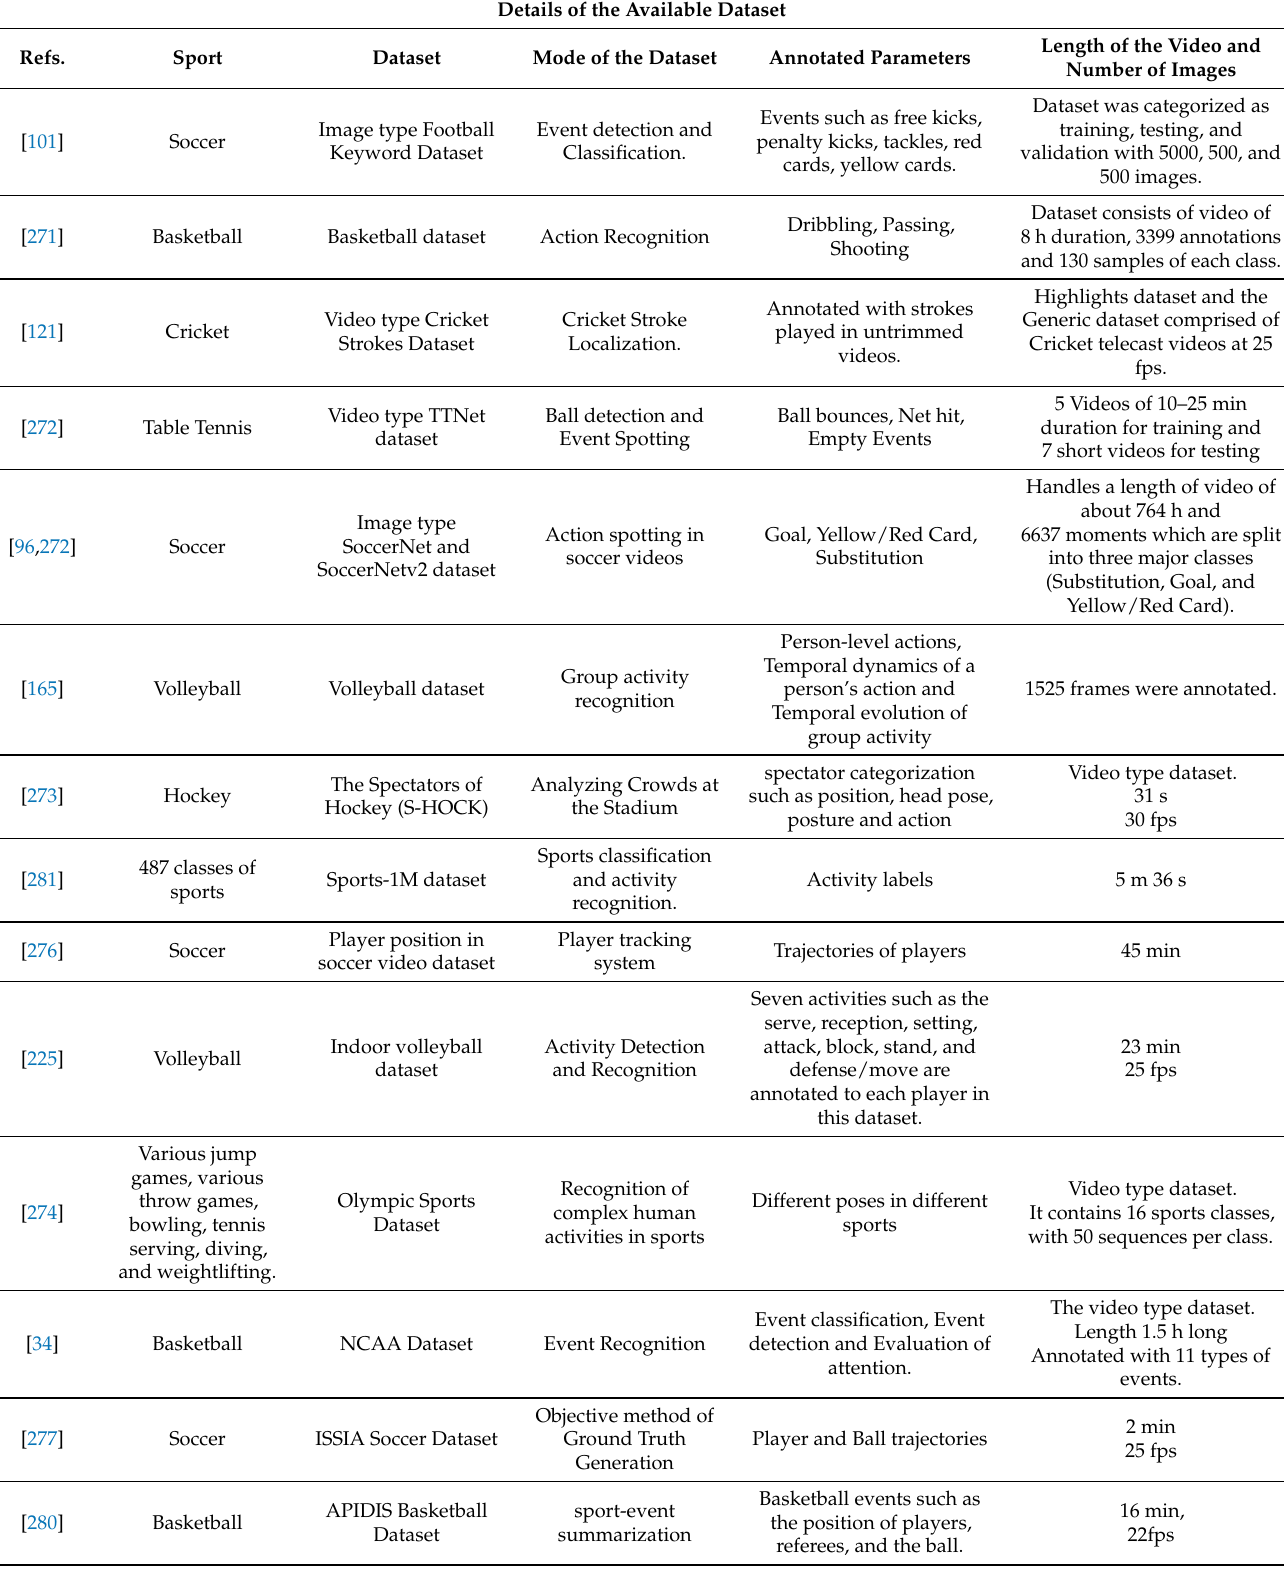
Table 10. Details of the available